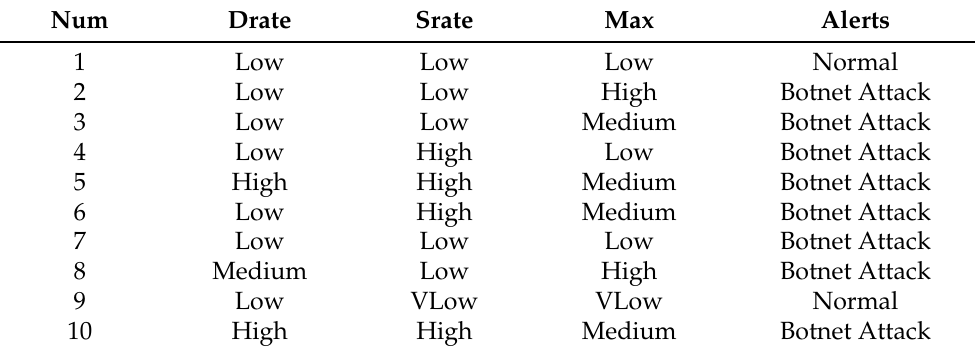
Table 1. The Optimized Sparse Botnet Detection